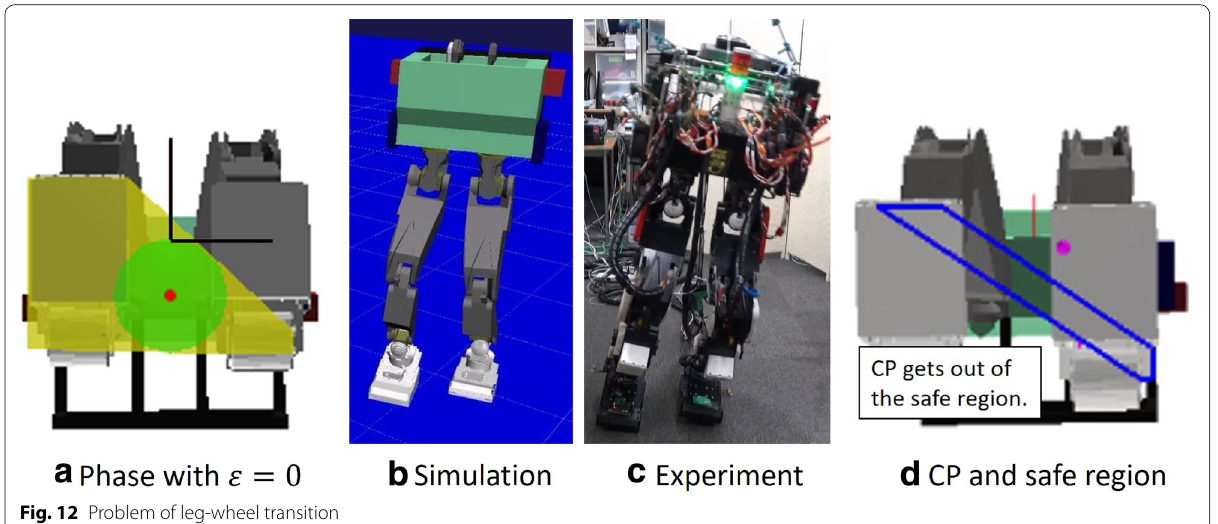
Fig. 12 Problem of leg-wheel